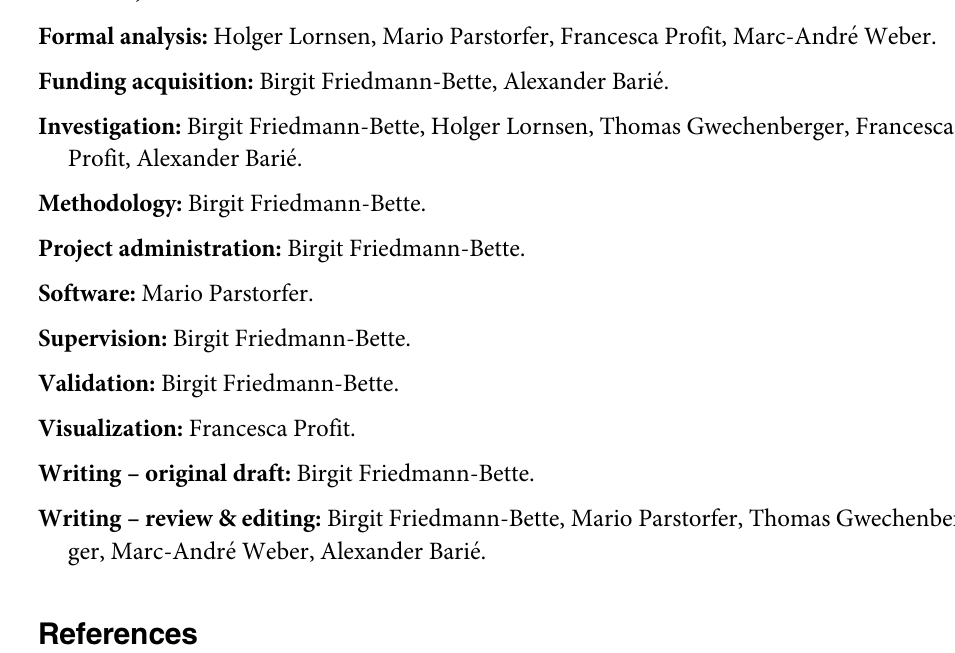
S1 Fig. Effects of 12 wk one-legged CON/ECC or CON/ECC + leg-press training on muscle cross sectional area (MCSA), fiber cross sectional area (FCSA) and fiber type distribution. Mean ± SE are shown. #: Significant group x time effect (p < 0.05); §: Significant time effect (p = 0.001); �� : p < 0.01, ��� : p < 0.001 compared with the respective value before training. S1 File. Data set. Individual data points of all